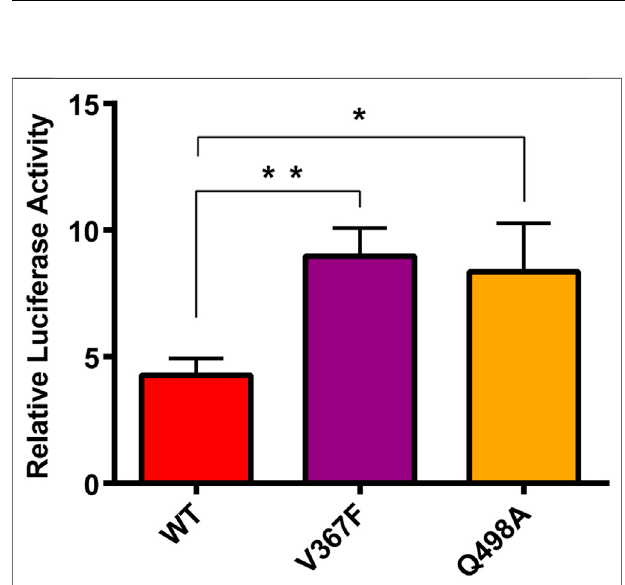
FIGURE 8 | Cell-cell fusion assay analysis of the binding between mutated spike and ACE2. HEK293T cells expressing with pcDNA3.1-spike/ mutant spike were co-incubated with cells expressing ACE2. After 48 h, Cells were lysis and the luciferase activity were detected. One-way ANOVA and Sidak ’ s multiple comparisons test were performed by GraphPad PRISM 6. * p < 0.05; ** p <